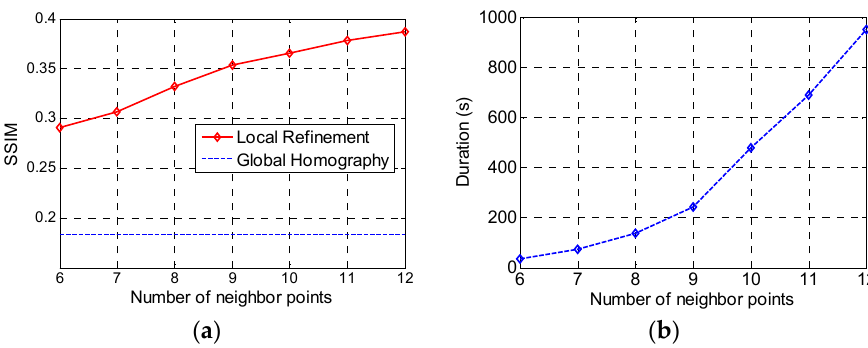
Figure 8. ( a ) Global SSIM between transformed and reference images vs. number of neighbor points, N K . ( b ) Duration (s) vs. number of neighbor points, N K .